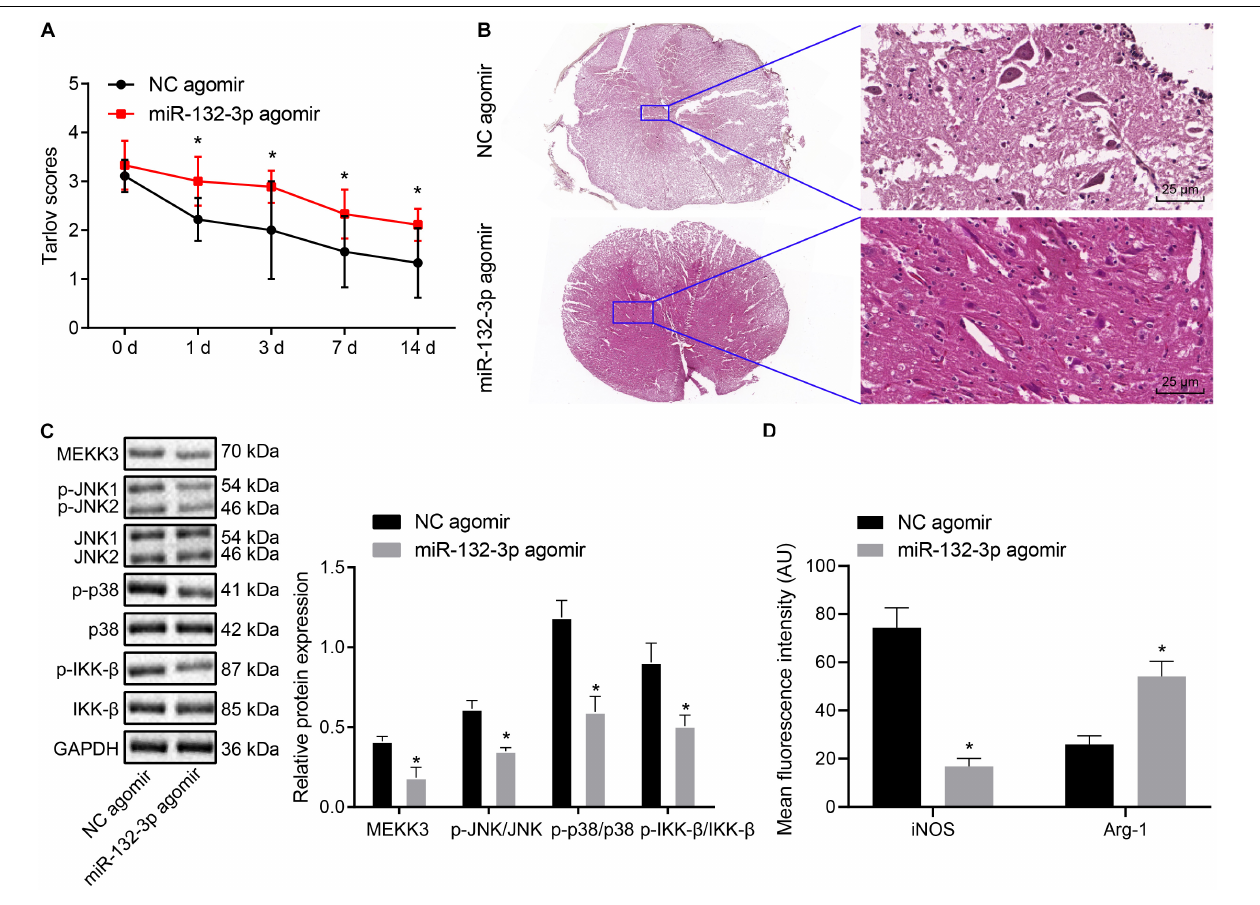
FIGURE 6 | miR-132-3p ameliorates SCIR injury in vivo . SCIR injury rats were treated with miR-132-3p agomir or NC agomir. (A) Motor function of rats assessed by Tarlov score. (B) Histological characteristics of spinal cord tissues of rats observed using HE staining. (C) The protein level of MEKK3, JNK, p38, and IKK- β as well as the phosphorylated JNK, p38, and IKK- β levels measured by Western blot analysis in rat spinal cord tissues. (D) Expression of iNOS and Arg-1 in spinal cord tissues of rats detected by immunofluorescence staining. * p < 0.05 vs. rats treated with NC agomir. Measurement data were expressed as mean ± standard deviation. n = 9 for rats following each treatment. Differences between two groups were compared by unpaired t -test. The data in panel (A) were analyzed by repeated measures